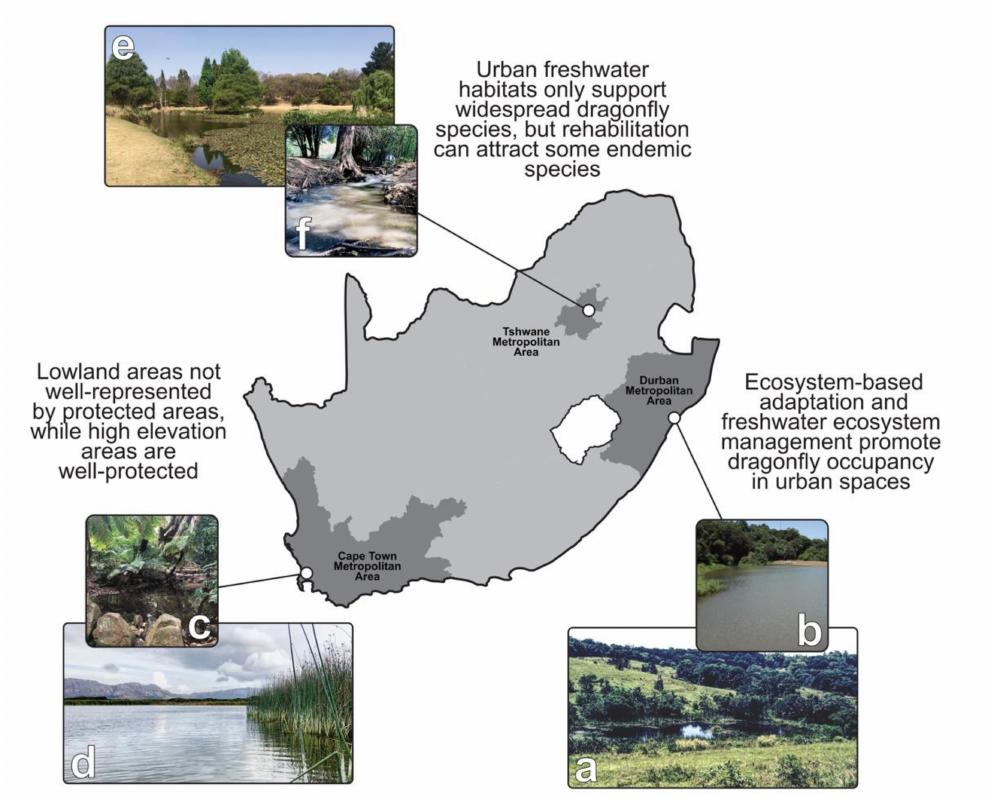
Figure 3. The three largest metropolitan areas in South Africa present different challenges and opportunities for drag- onfly conservation. ( a ) A former sugarcane field now part of the Kenneth Stainbank Nature Reserve, ( b ) a dragonfly conservation pond in Pietermaritzburg Botanical Gardens, ( c ) a high elevation mountain stream within the Table Mountain National Park, ( d ) a heavily impacted wetland in the lowlands of the Cape Floristic Region, ( e ) an urban lake in the heart of the Tshwane Metropolitan Area, formerly used as an irrigation reservoir, and ( f ) an impacted stream in a suburban area now being